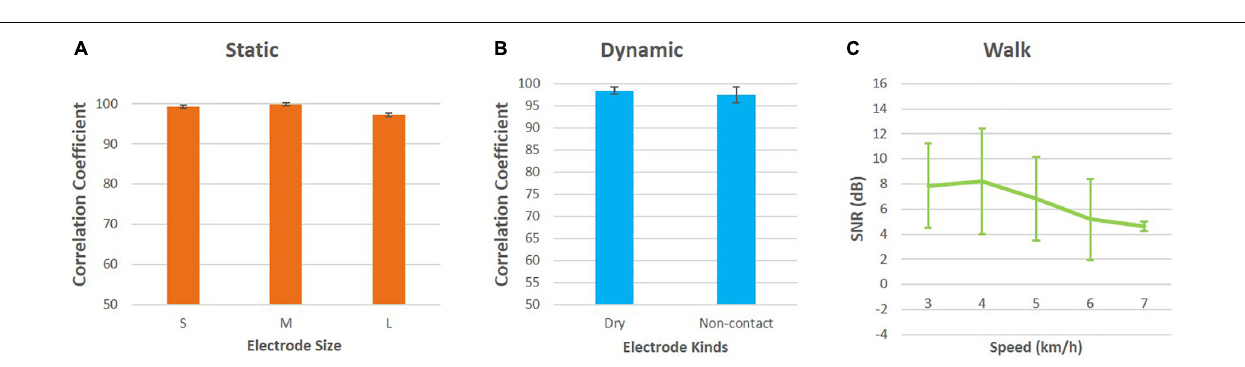
FIGURE 5 | The ECG signals recorded by wet (blue) and flexible non-contact electrode (red) under different walking speeds (from left to right and from up to down, they were 2, 3, 4, 5, 6, and 7 km/h, respectively).